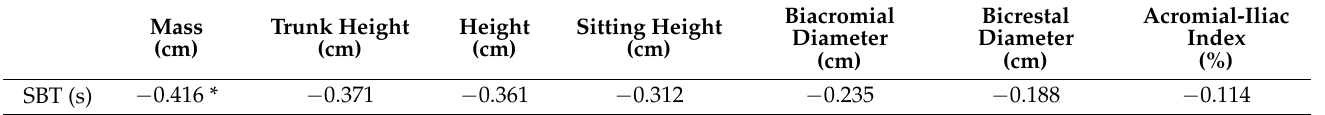
Table 4. Correlations between the anthropometric variables and the side bridge test endurance time